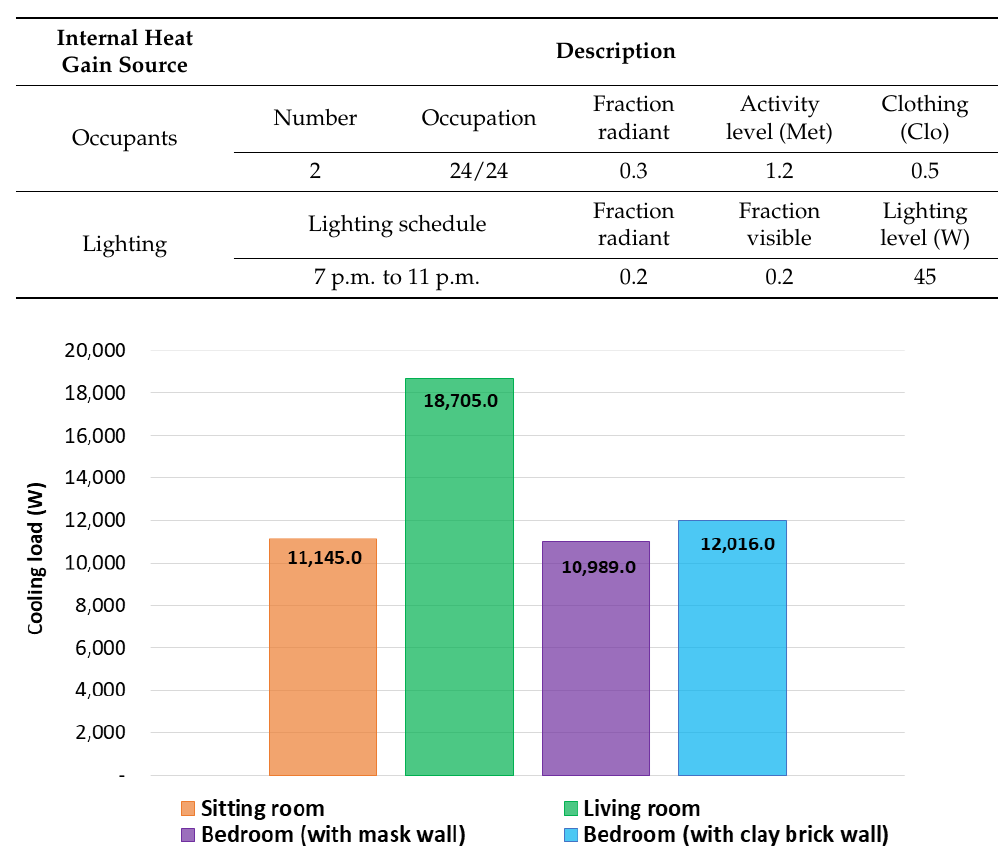
Figure 18. Daily cooling loads considering the internal heat gain sources.